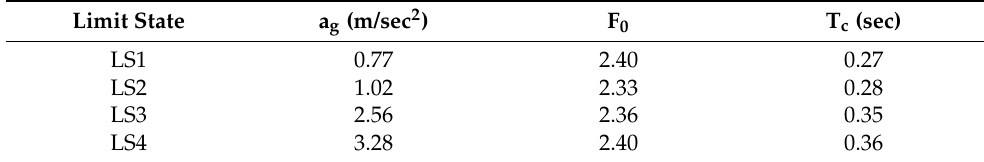
Table 2. Spectral parameters of the selected site.